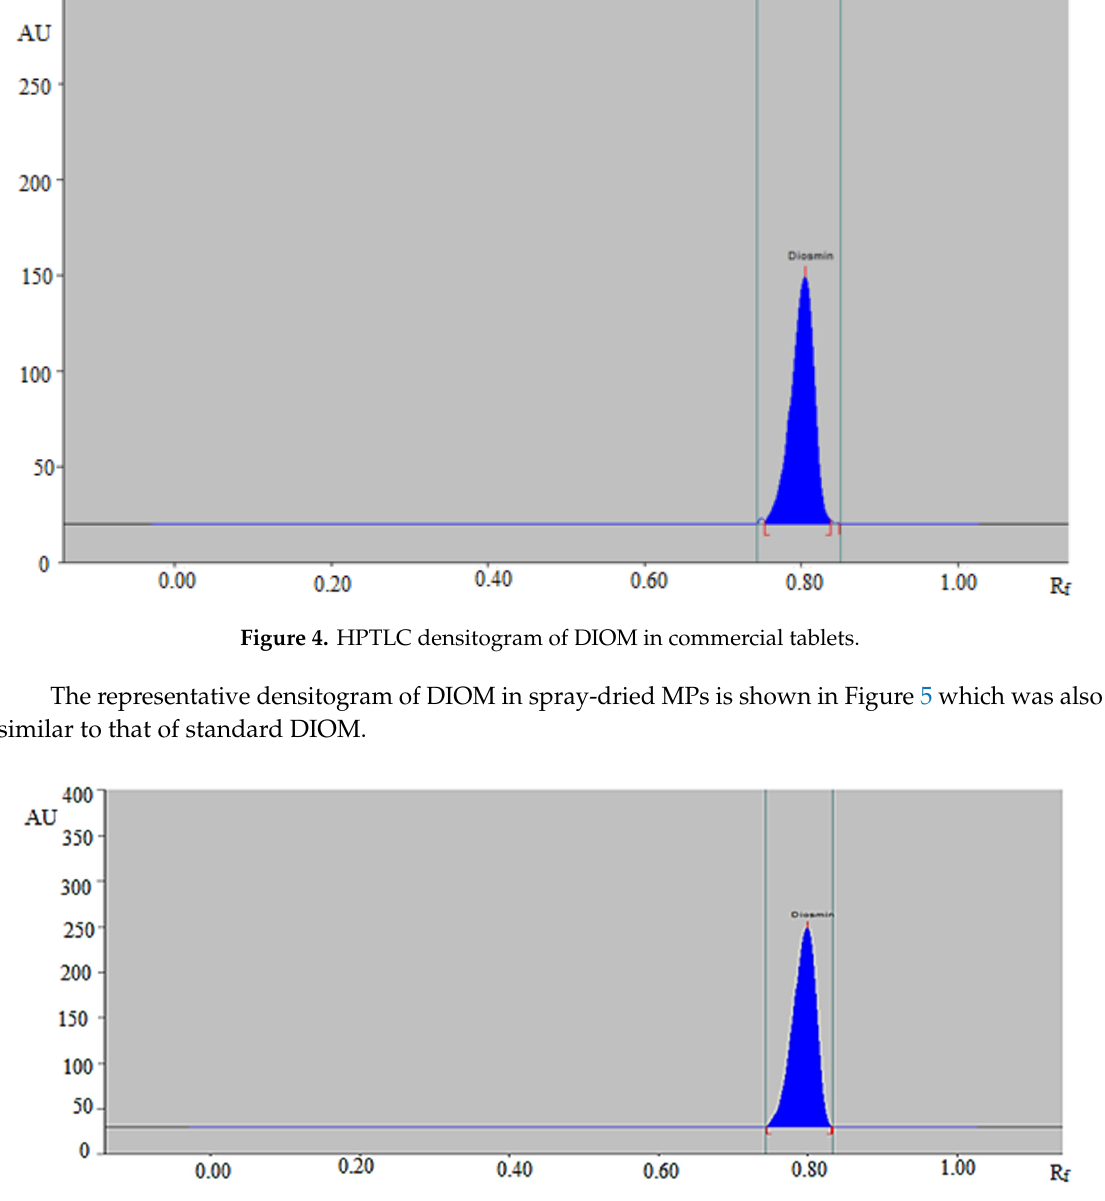
Figure 5. HPTLC densitogram of DIOM in in-house developed spray-dried MPs.